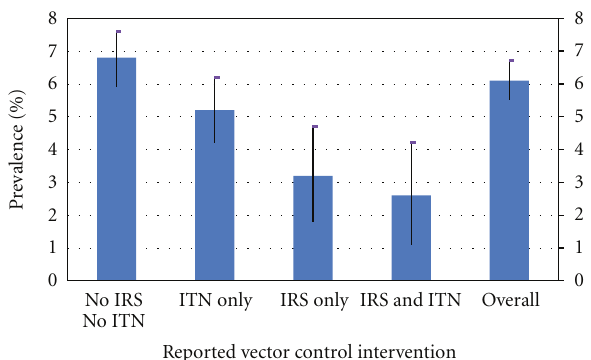
Figure 6: Prevalence of infection in children 1 to < 15 years of age in Zambia by reported vector control intervention (2008, 2009, and 2010 combined). IRS: Indoor Residual Spraying; ITN: Insecticide Treated